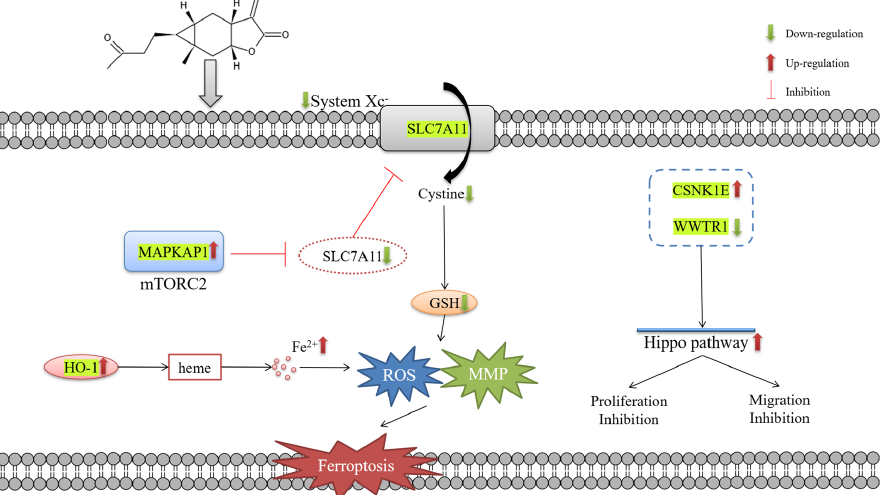
Figure 5. Schematic figure of the cancer inhibition mechanism of carabrone in pancreatic cancer.